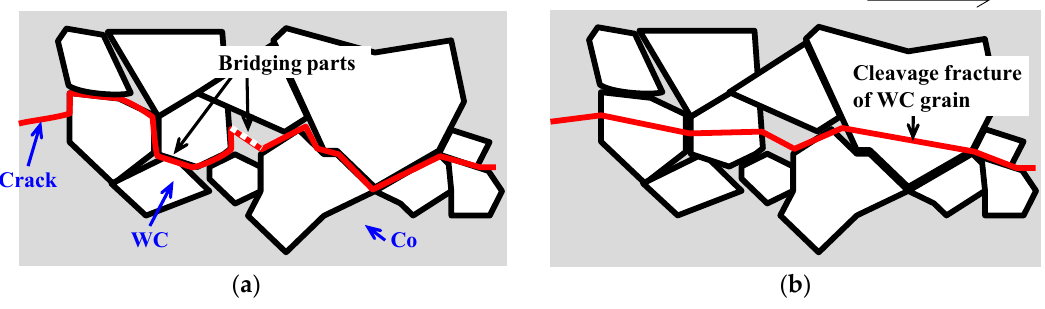
Figure 15. Schematic illustration of the effect of K max on the FCG path: ( a ) at low K max (WC/WC interface, bridging parts); ( b ) at high K max (cleavage fracture of WC grains). interface, bridging parts); ( b ) at high K max (cleavage fracture of WC